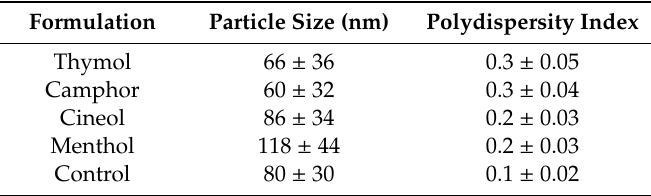
Table 1. Invasome Particle Size and the Polydispersity Index .